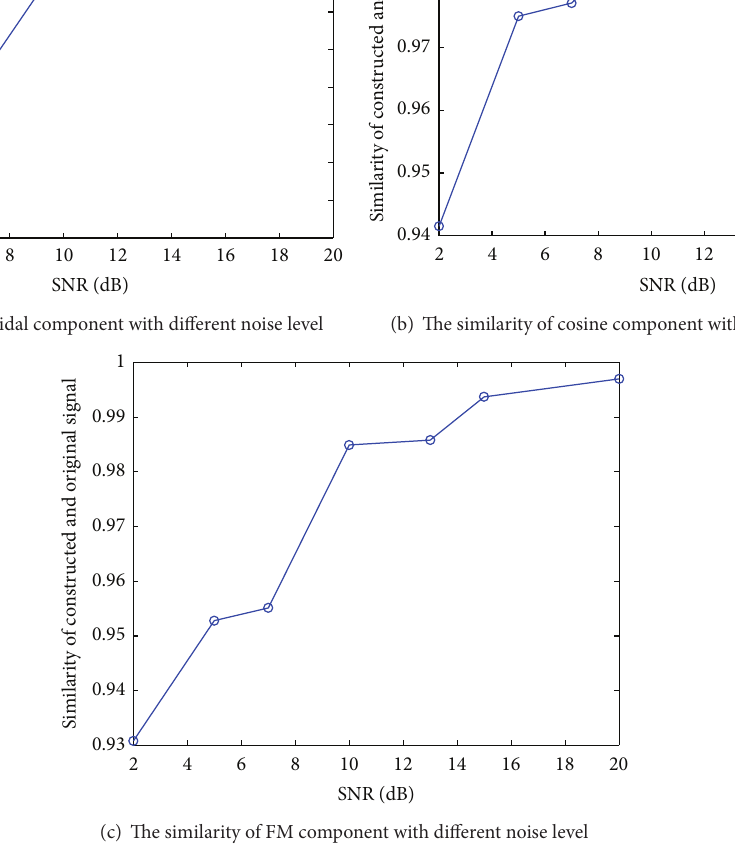
Figure 5: The results of VMD decomposition with varied noise level.